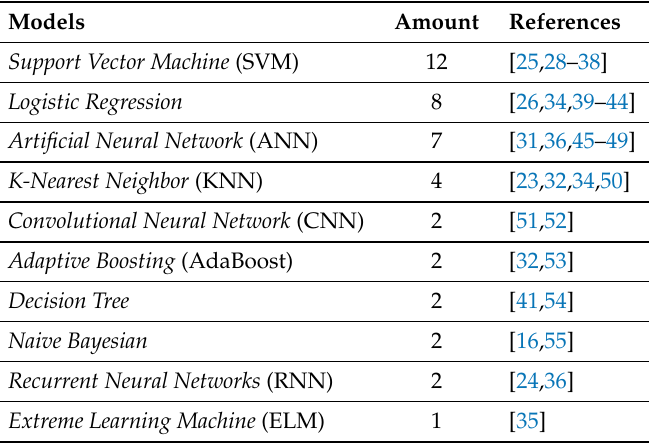
Table 4. List of machine-learning (ML) approaches filtered in the literature review. This table lists the number of works that have developed ML models in the context of driver